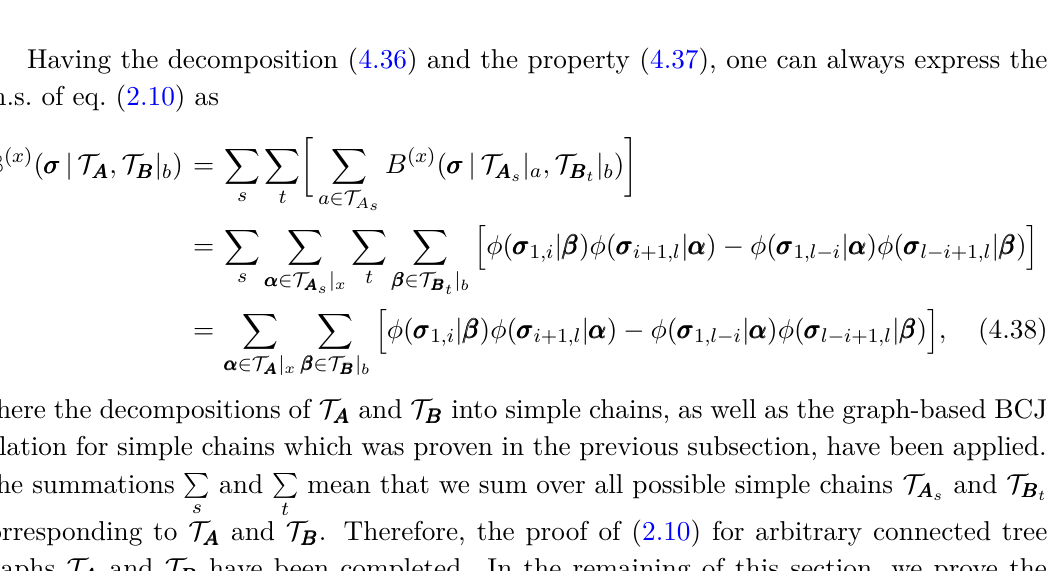
is inserted at the positions that occur after a l